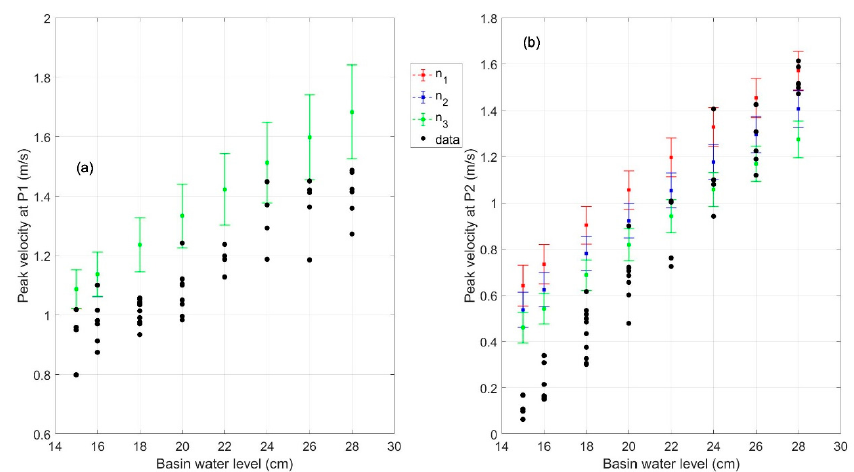
Figure 6. Peak flow velocities at ( a ) P1 and ( b ) P2. Numerical results for P1 are obtained with the friction coefficient n = 0.0125 m − 1/3 s, while for P2 are obtained by using different coef fi cients on the slope ( n 1 = 0.0125 m − 1/3 s, n 2 = 0.0175 m − 1/3 s, n 3 = 0.0225 m − 1/3 s). Error bars cover the full range of values obtained by varying h 1 for a given n .